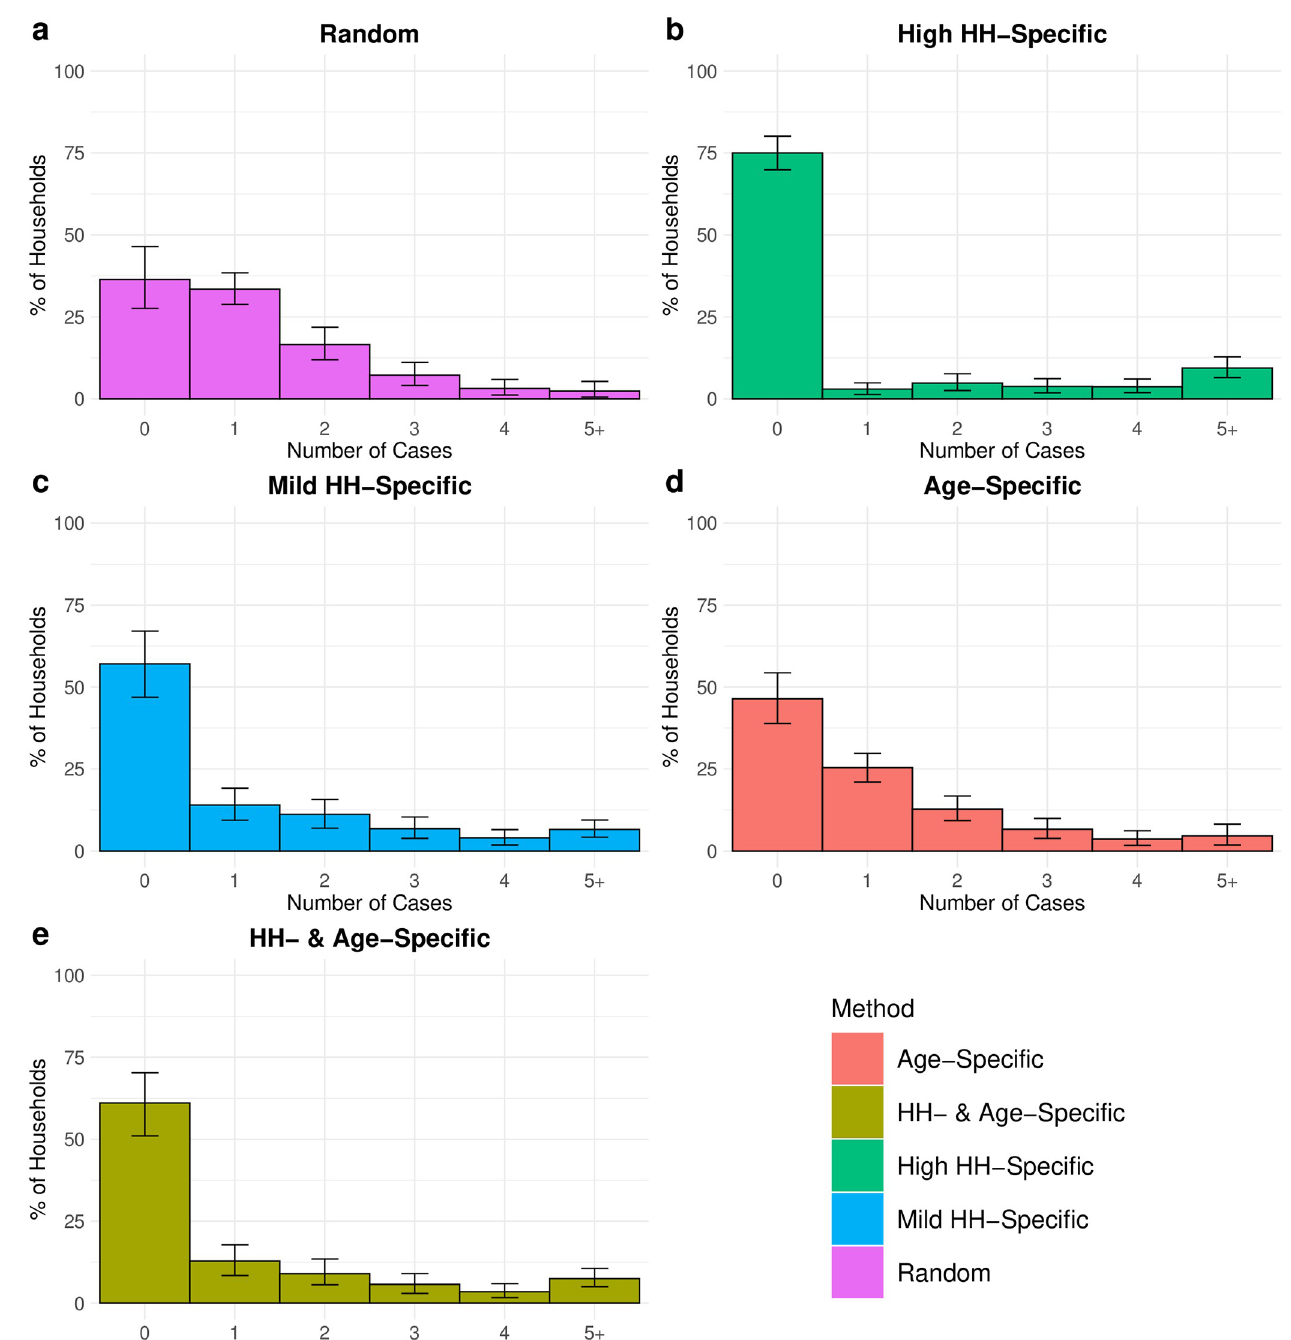
Fig 5. The percentage of households where there are 0, 1, 2, 3, 4, 5+ cases across the different methods of scabies status assignment. The results (median and 2.5% to 97.5% quantiles) are plotted for an exemplar input prevalence percentage between 20–30% across all population